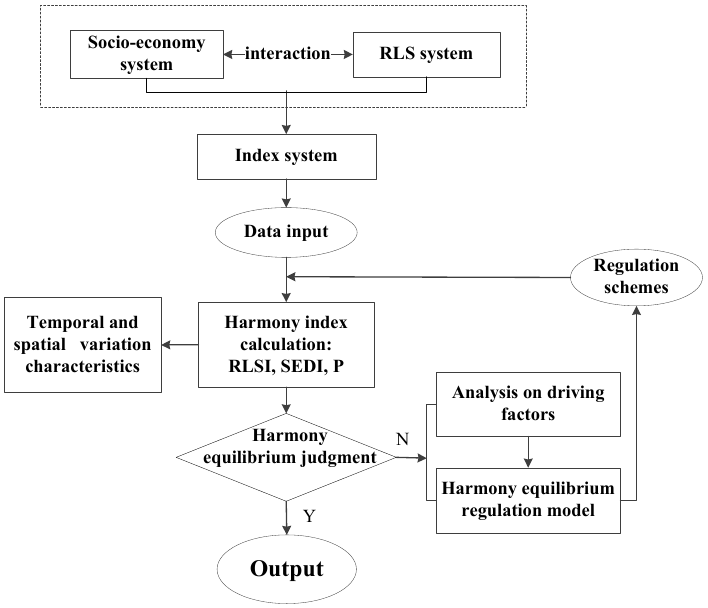
Figure 2. Framework of harmonious development between socio-economy and river-lake water systems (RLS) in Xiangyang City.